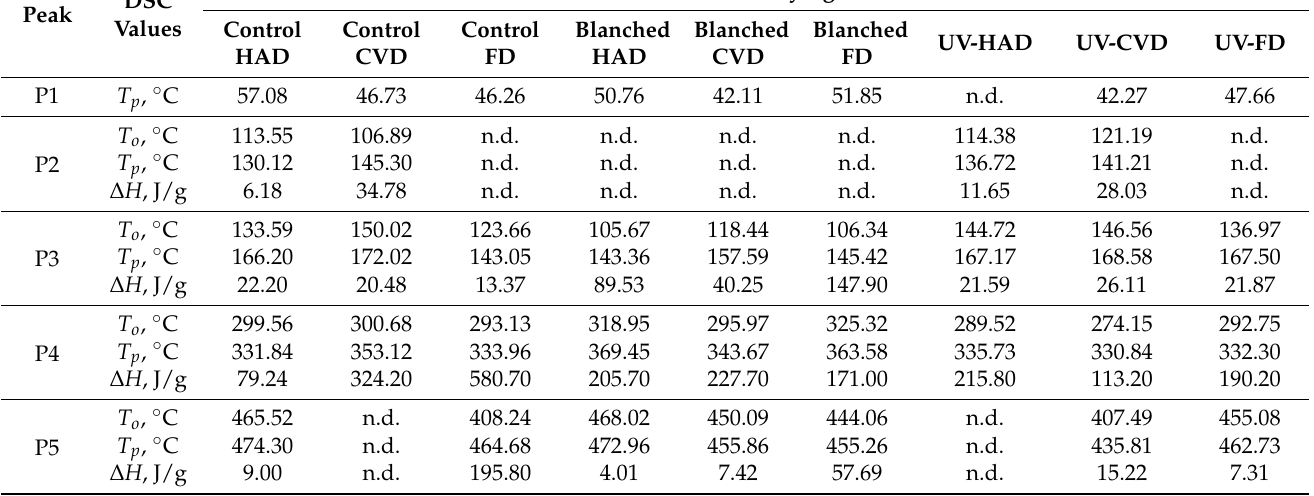
Table 3. Characteristic temperatures and enthalpy from the DSC investigation of dried B. edulis